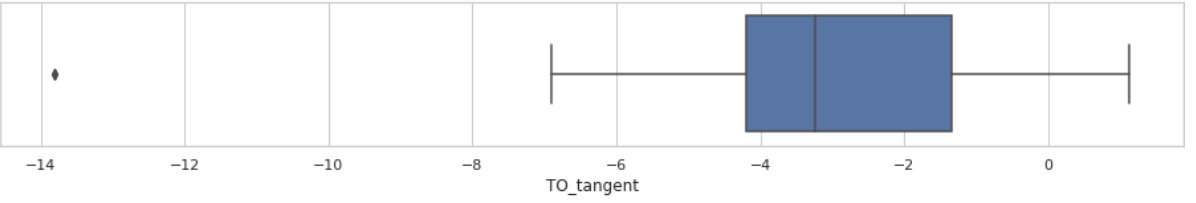
Figure 7. Distribution of the feature values after logarithmic transformation.